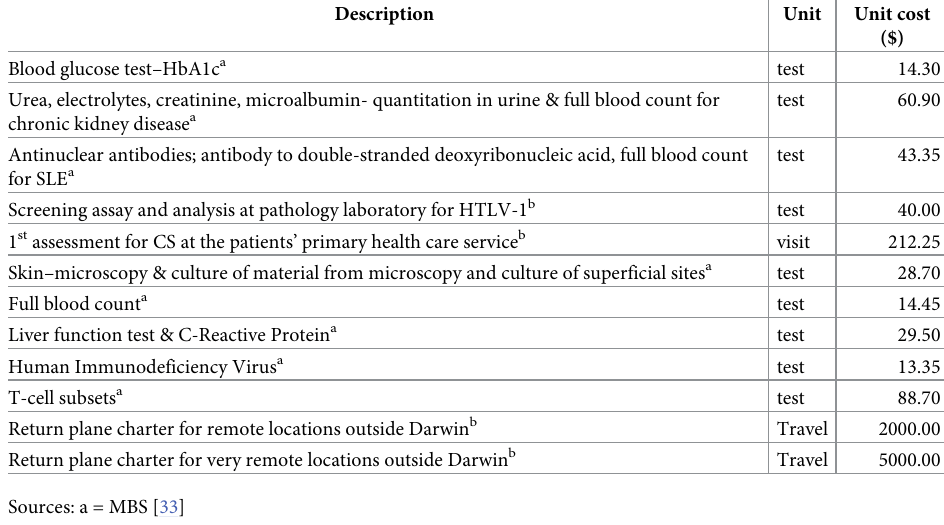
Table 1. Unit costs for resources used during the initial assessment of